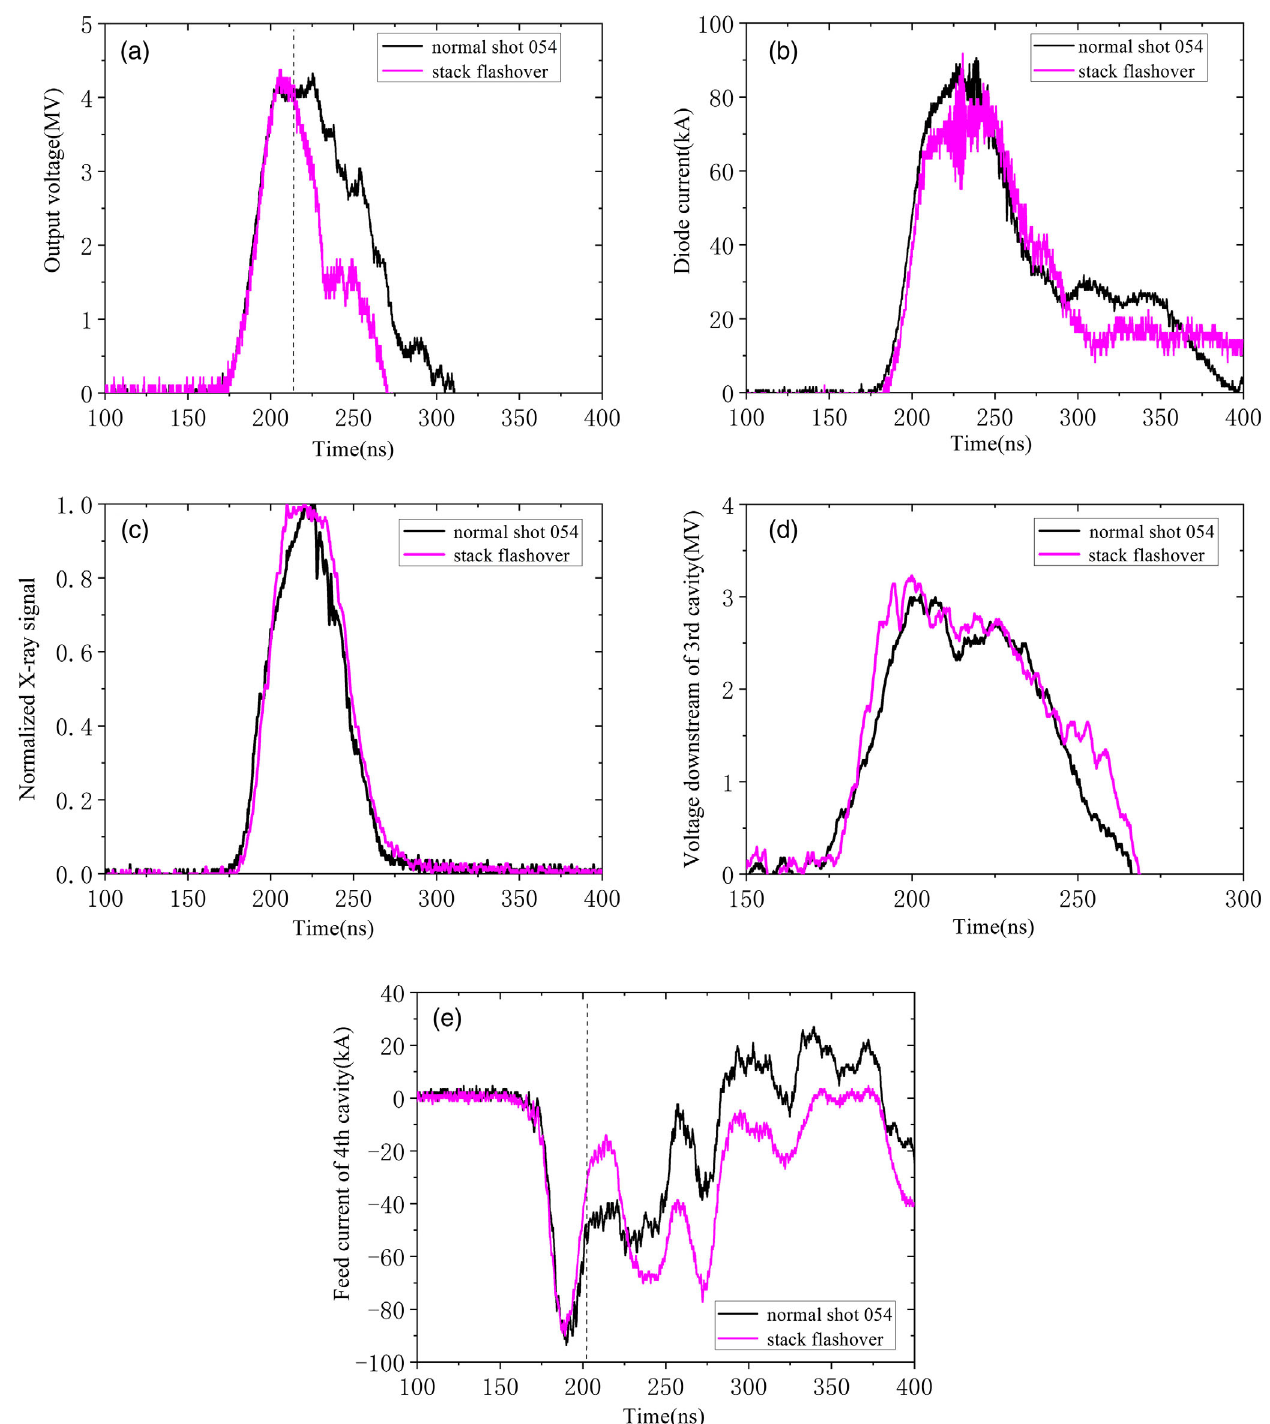
FIG. 10. Comparison of electrical measurements between the insulator-stack-flashover shot 028 (fuchsia traces) and the normal shot 054 (black traces). (a) Output voltage, (b) diode current, (c) normalized x-ray signals, (d) voltage downstream of the third cavity, and (e) feed current of the fourth